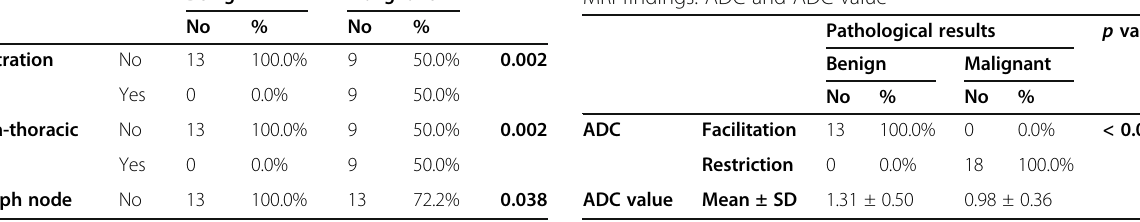
Table 1 Comparison between pathological results as regards MRI findings: infiltration, intra-thoracic, and lymph node Benign